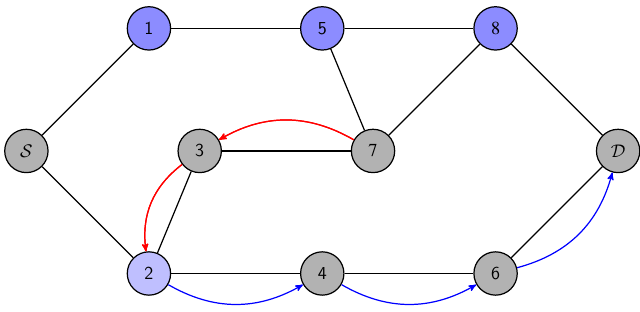
Figure 3. Backtracking illustration: there is no way out from node 7 to destination D , because nodes 5 and 8 are